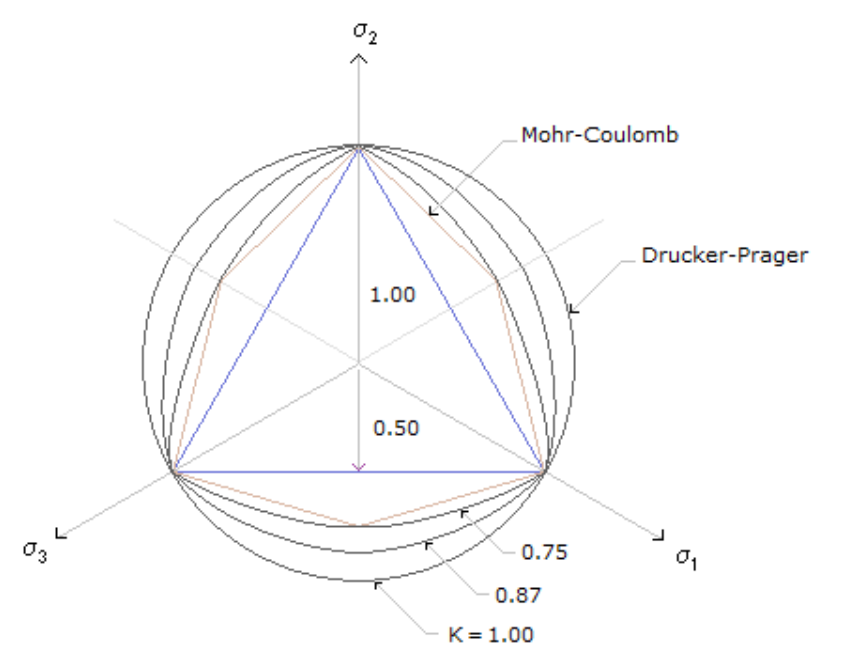
Figure 7. Shape of the strength envelope, R ( θ ) , in an octahedral plane.